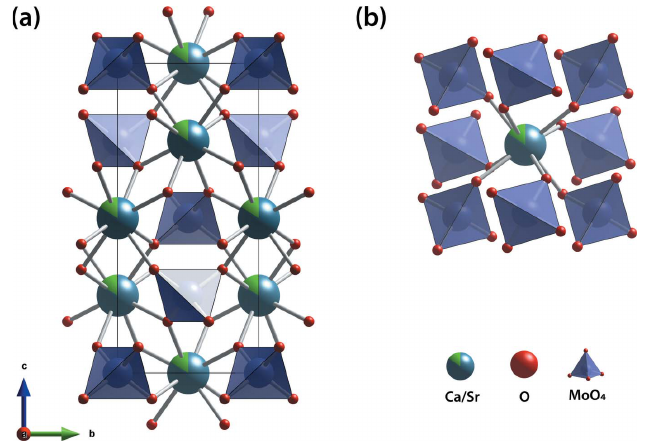
Figure 1 ( a ) Crystal structure of Ca 0.84 Sr 0.16 MoO 4 and ( b ) coordination of eight [MoO 4 ] 2 (cid:3) tetrahedra with respect to the Ca/Sr